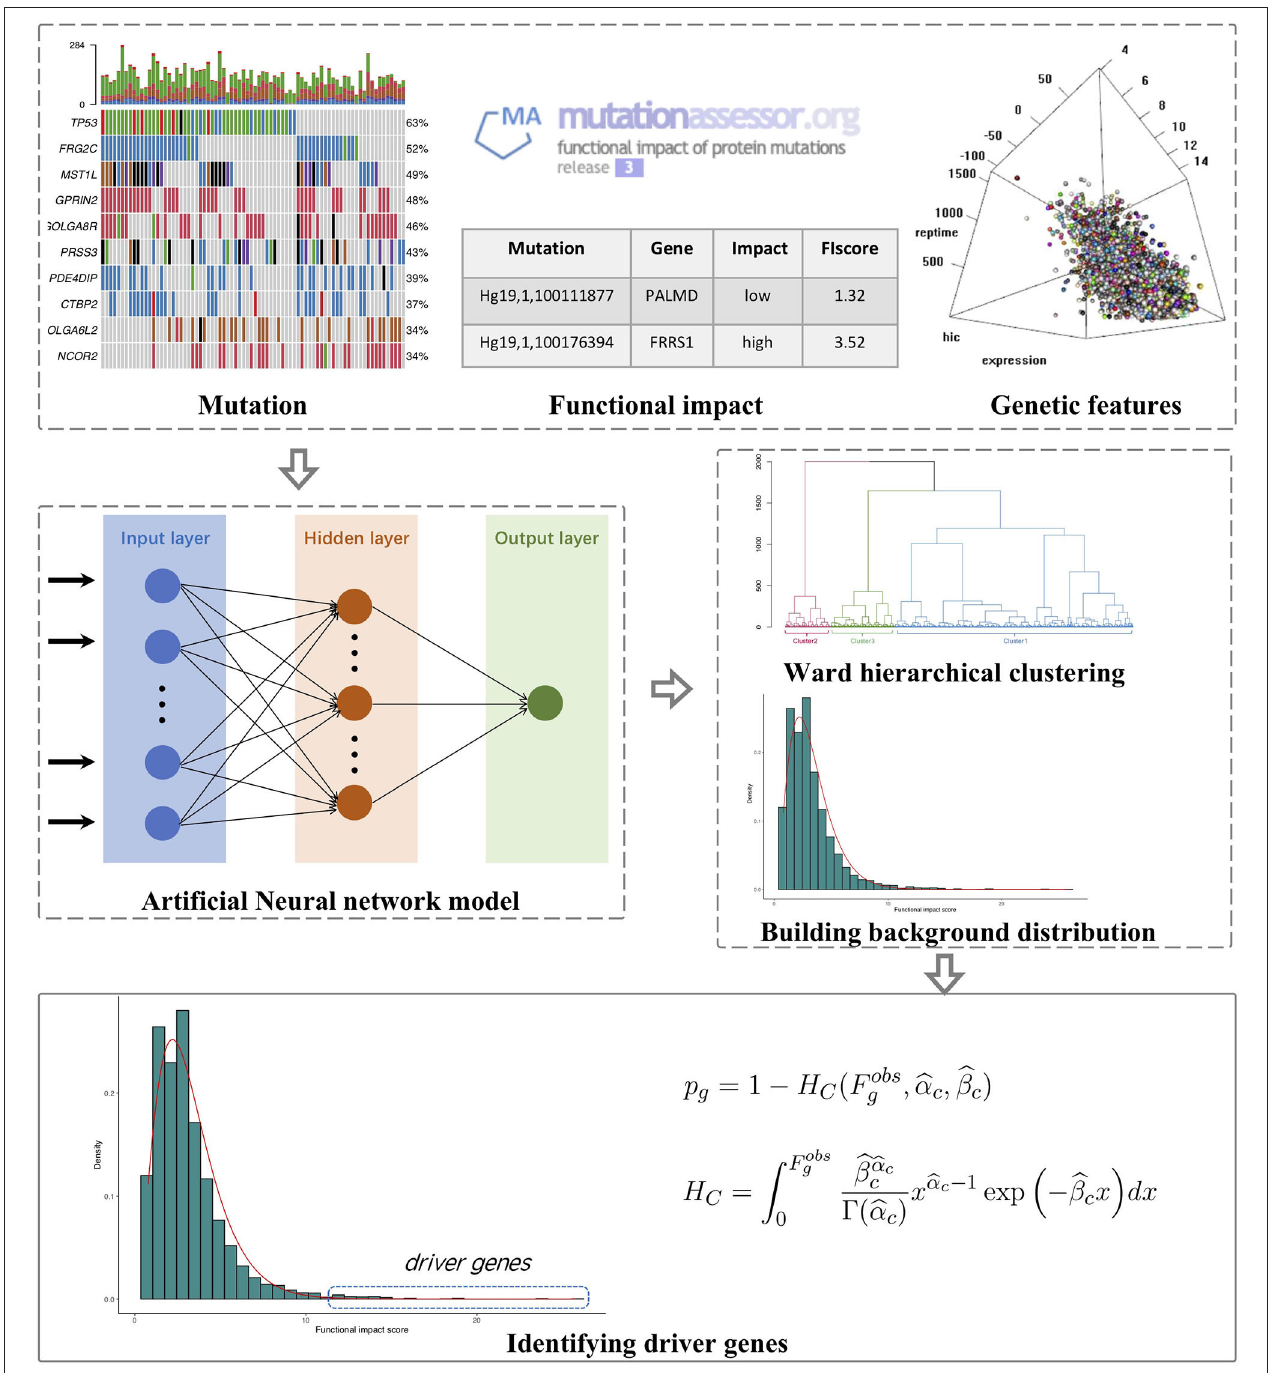
FIGURE 1 | The workflow of functional impact prediction neural network (FI-net) method. The observed functional impact scores (FISs) of genes are calculated on the basis of mutation data from Mutation Annotation Format (MAF) file and the FISs of mutations from MutationAssessor. Then, the background distribution of FISs is estimated by using the artificial neural network and hierarchical clustering algorithm with multi-omics features as input. Based on these, driver genes are identified by comparing the observed FIS to the background distribution.